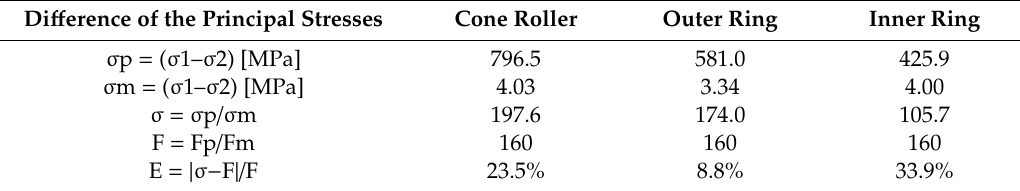
Table 5. Comparison of